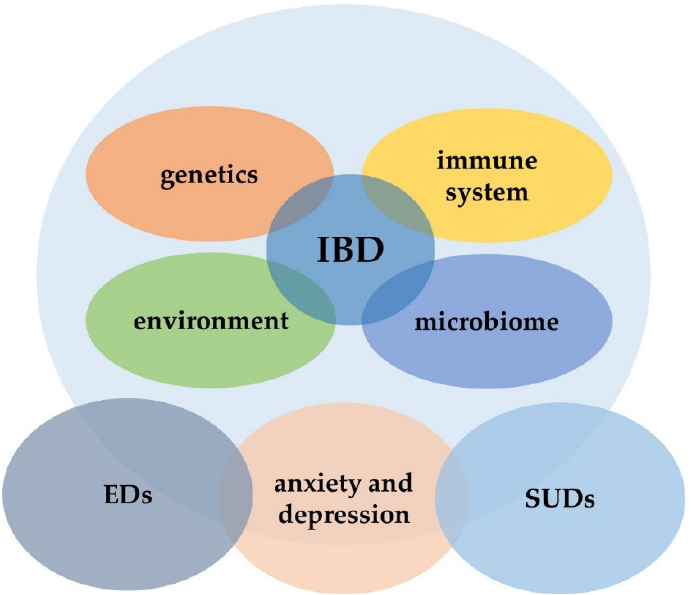
Figure 1. Interactions between IBD and psychiatric disorders. IBD, inflammatory bowel disease; EDs, eating disorders; SUDs, substance use disorders.